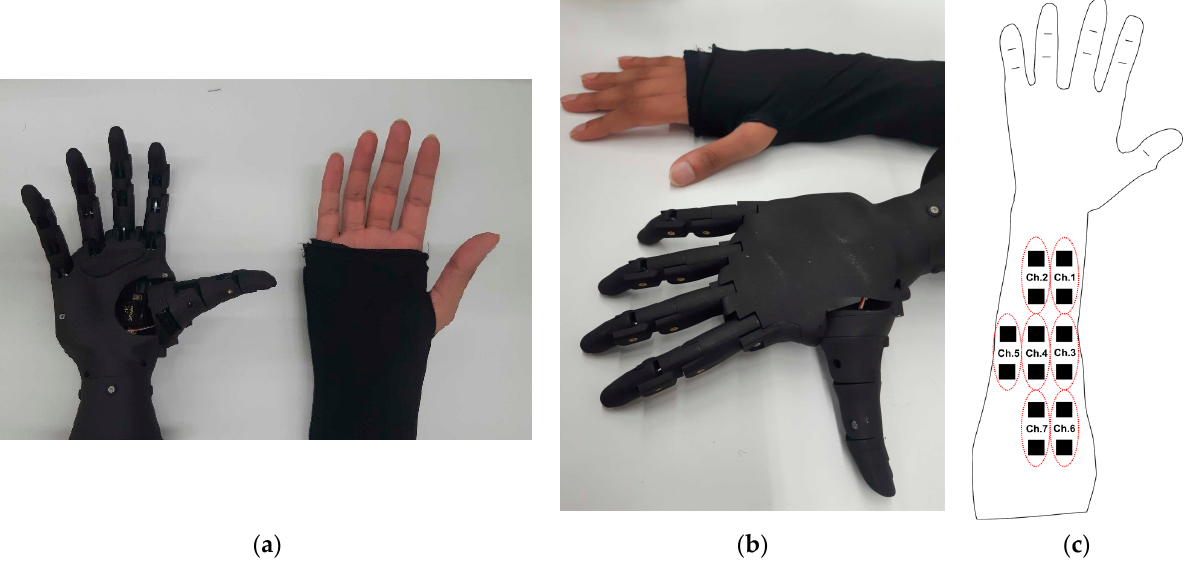
Figure 2. The myoelectric prosthetic hand and the EMG sleeve used in this study: ( a ) Top-view; ( b ) Side-view; and ( c ) location and arrangement of the textile electrode array with respect to users’ right forearm.